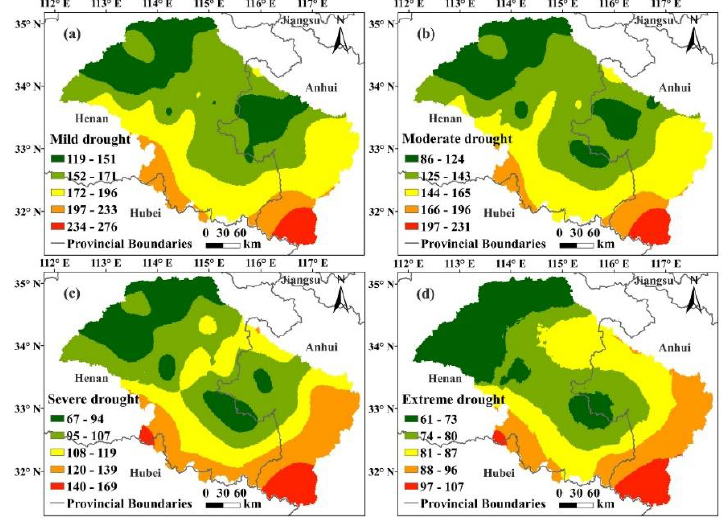
Figure 6. Spatial distribution of precipitation thresholds R (mm) of drought disaster at different levels during the critical water period during summer maize growth in the BHR: ( a ) mild drought, ( b ) moderate drought, ( c ) severe drought, and ( d ) extreme drought.